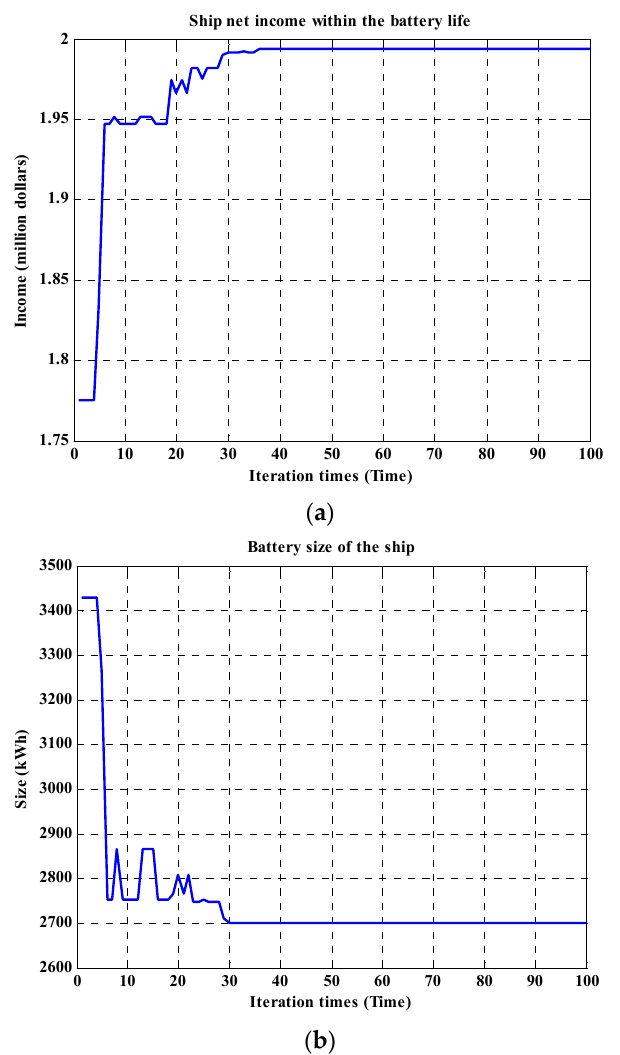
Figure 9. Simulation results of scenario 4 in case 1. ( a ) Variation of ship net income within the battery life over the optimization procedure ( b ) Battery capacity variation over the optimization procedure